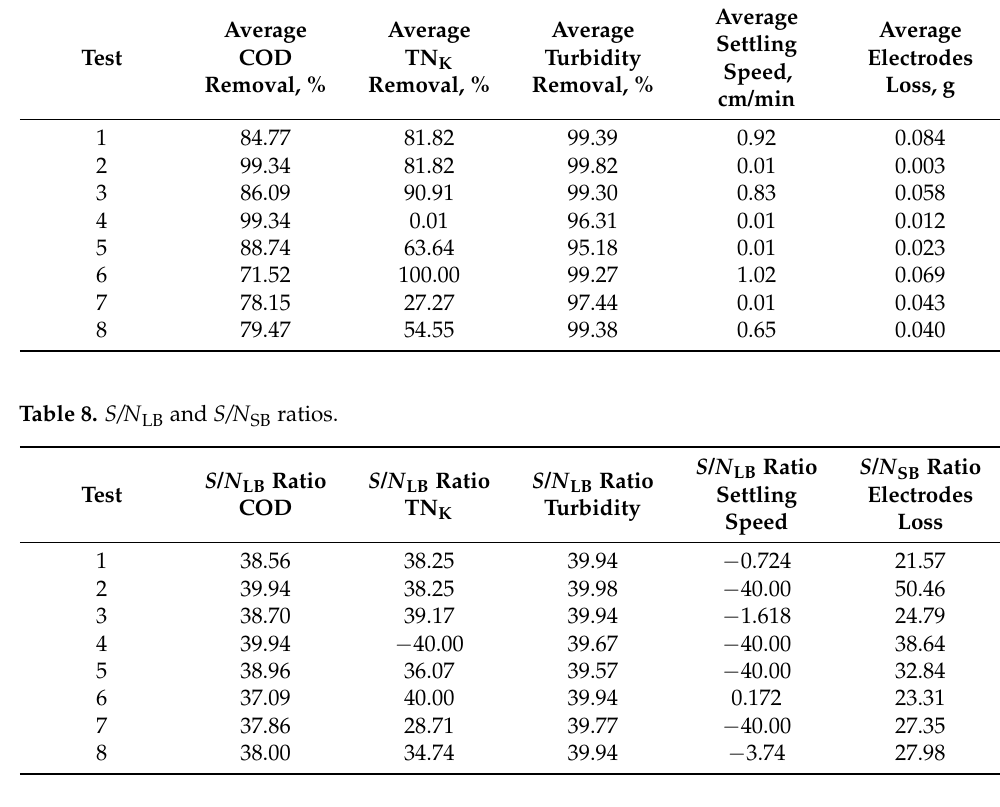
Table 7. Results of experimental part of Taguchi design.